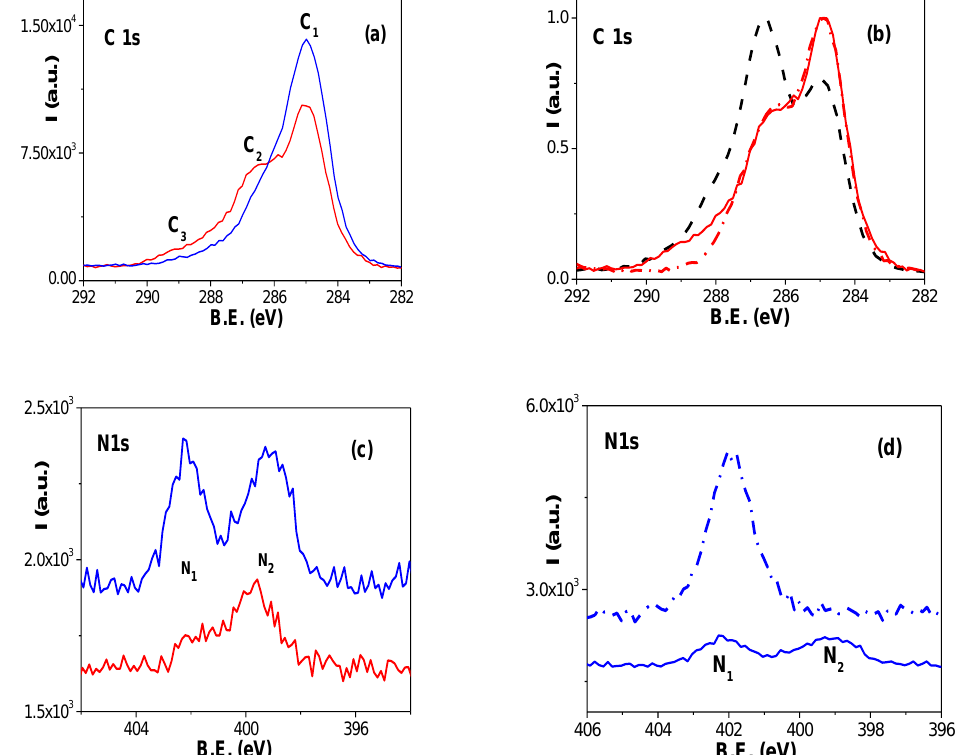
Figure 1. Core level spectra signals for: ( a ) C 1 s for RC/AliquatCl film (blue solid line) and RC/BMIMPF 6 film (red solid line); ( b ) comparison of normalized C 1 s signal for the RC/BMIMPF 6 film (red solid line), RC-support (black dashed line) and BMIMPF 6 IL (red dashed–dot line); ( c ) N 1 s (blue solid line) for RC/AliquatCl film and red solid line for RC/BMIMPF 6 film; ( d ) comparison of N 1s signal for the IL AliquatCl (blue dashed – dot line) and the RC/Aliquat (blue solid line).